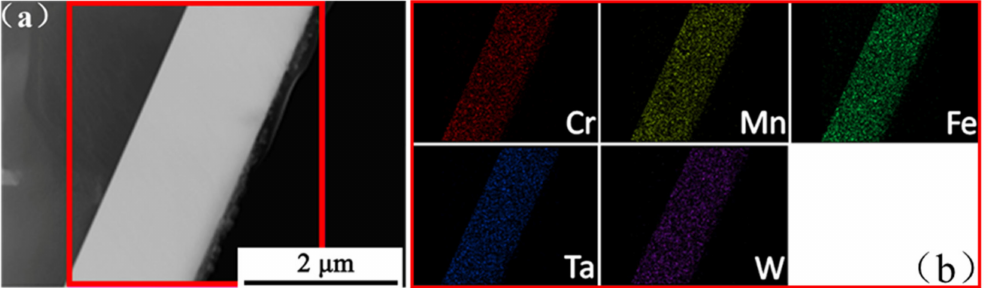
Figure 2. The as-deposited Cr 20 Mn 17 Fe 18 Ta 23 W 22 : ( a ) The cross-sectional HAADF image; ( b ) EDS- mapping